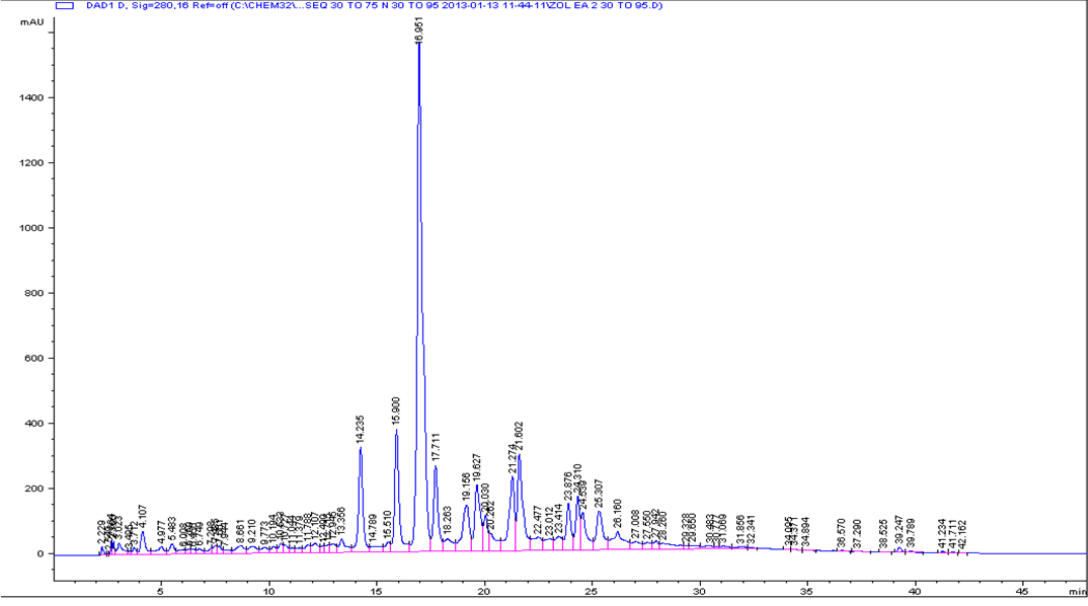
Figure 2. Analytical HPLC chromatogram for ZE4 sub-fraction.